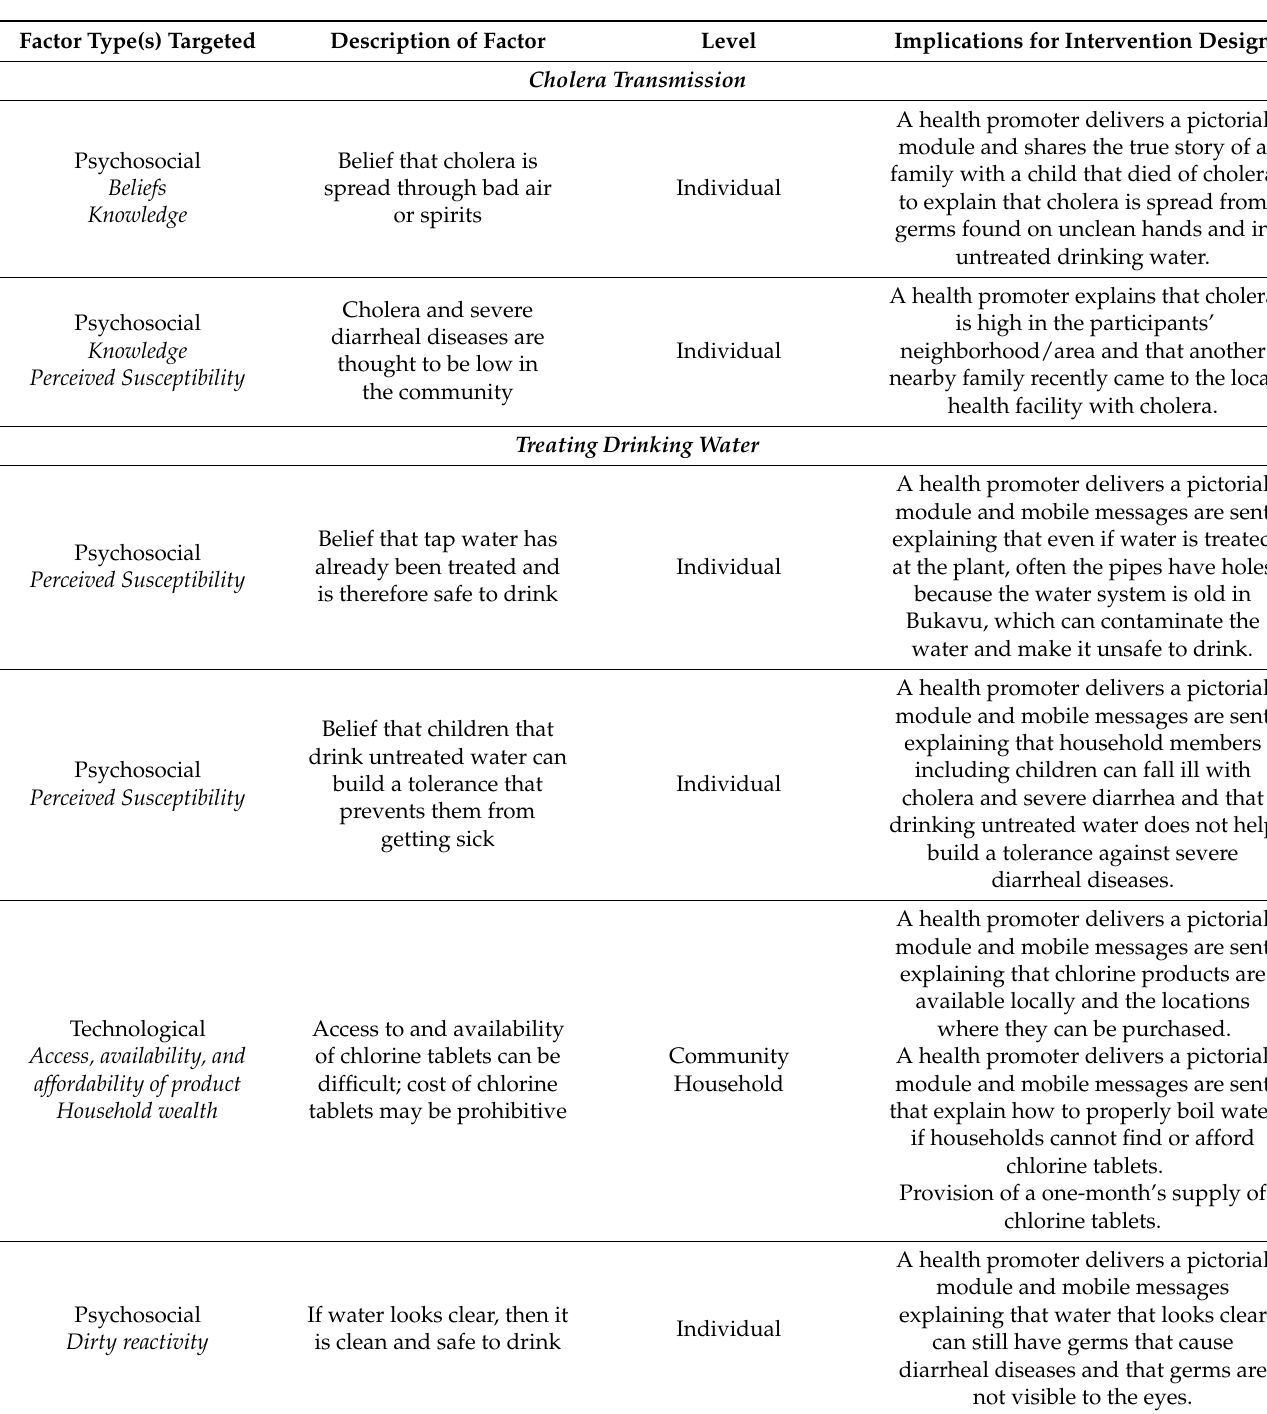
Table 2. Technological, contexual, and psychosocial factors targeted in the Development of